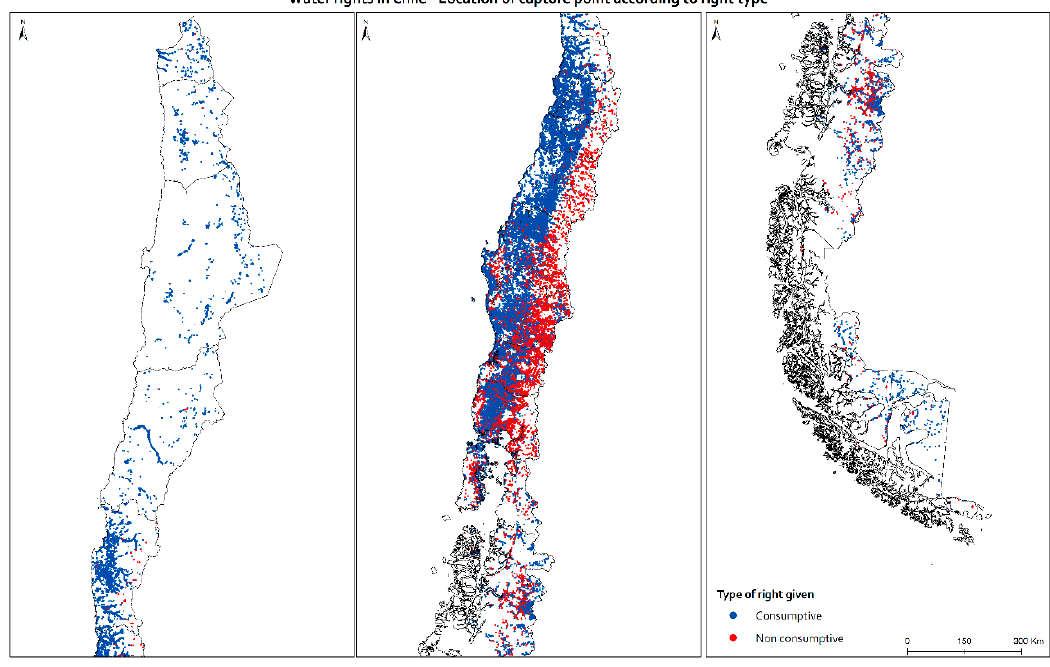
Figure 2. National map with the permits according to consumptive or non-consumptive rights. Source: Compiled by the authors based on information from the DGA.